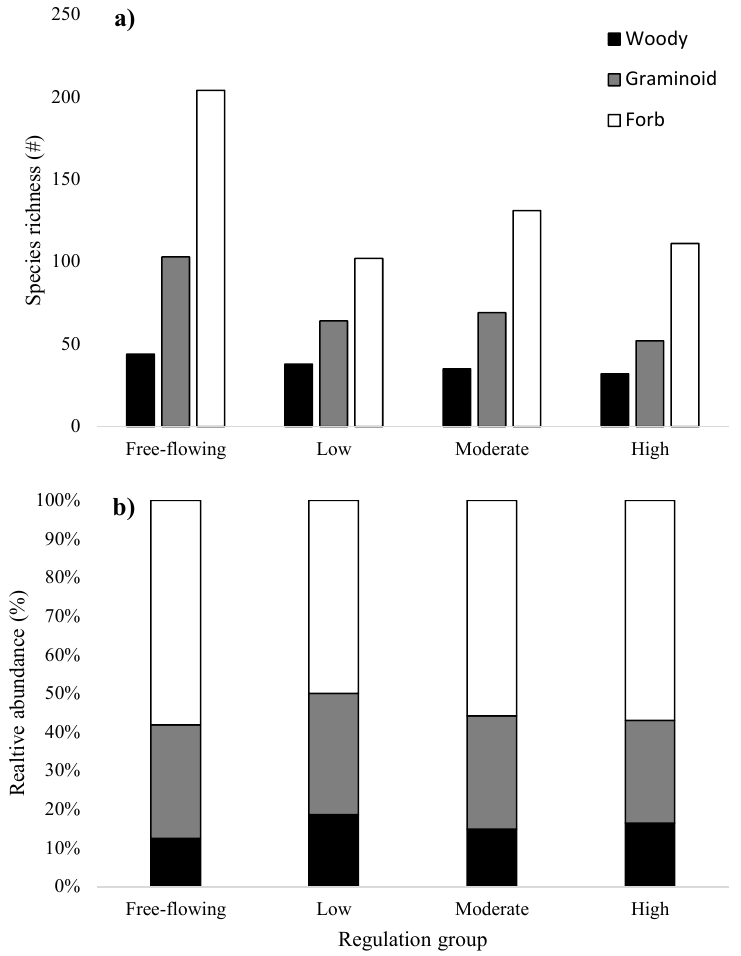
Figure 2. ( a ) Species richness within each life form group for each flow regulation group and ( b ) relative abundance of each life form group for each flow regulation group. Regulation groups involve the following levels of regulation: free-flowing ( < 0%), low ( > 0% and < 15%), moderate ( > 15% and < 60%), and high ( > 60%).